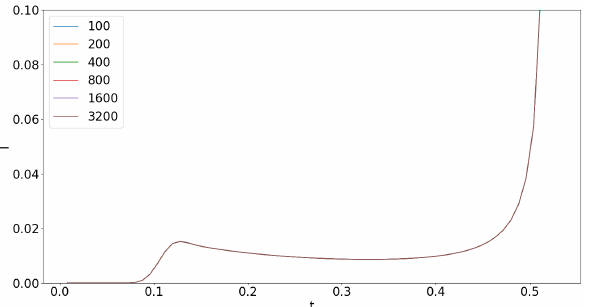
Figure 5. The Weyl invariant I along the right boundary with a = 3 for multiple z -resolutions which all fall within the same drawn